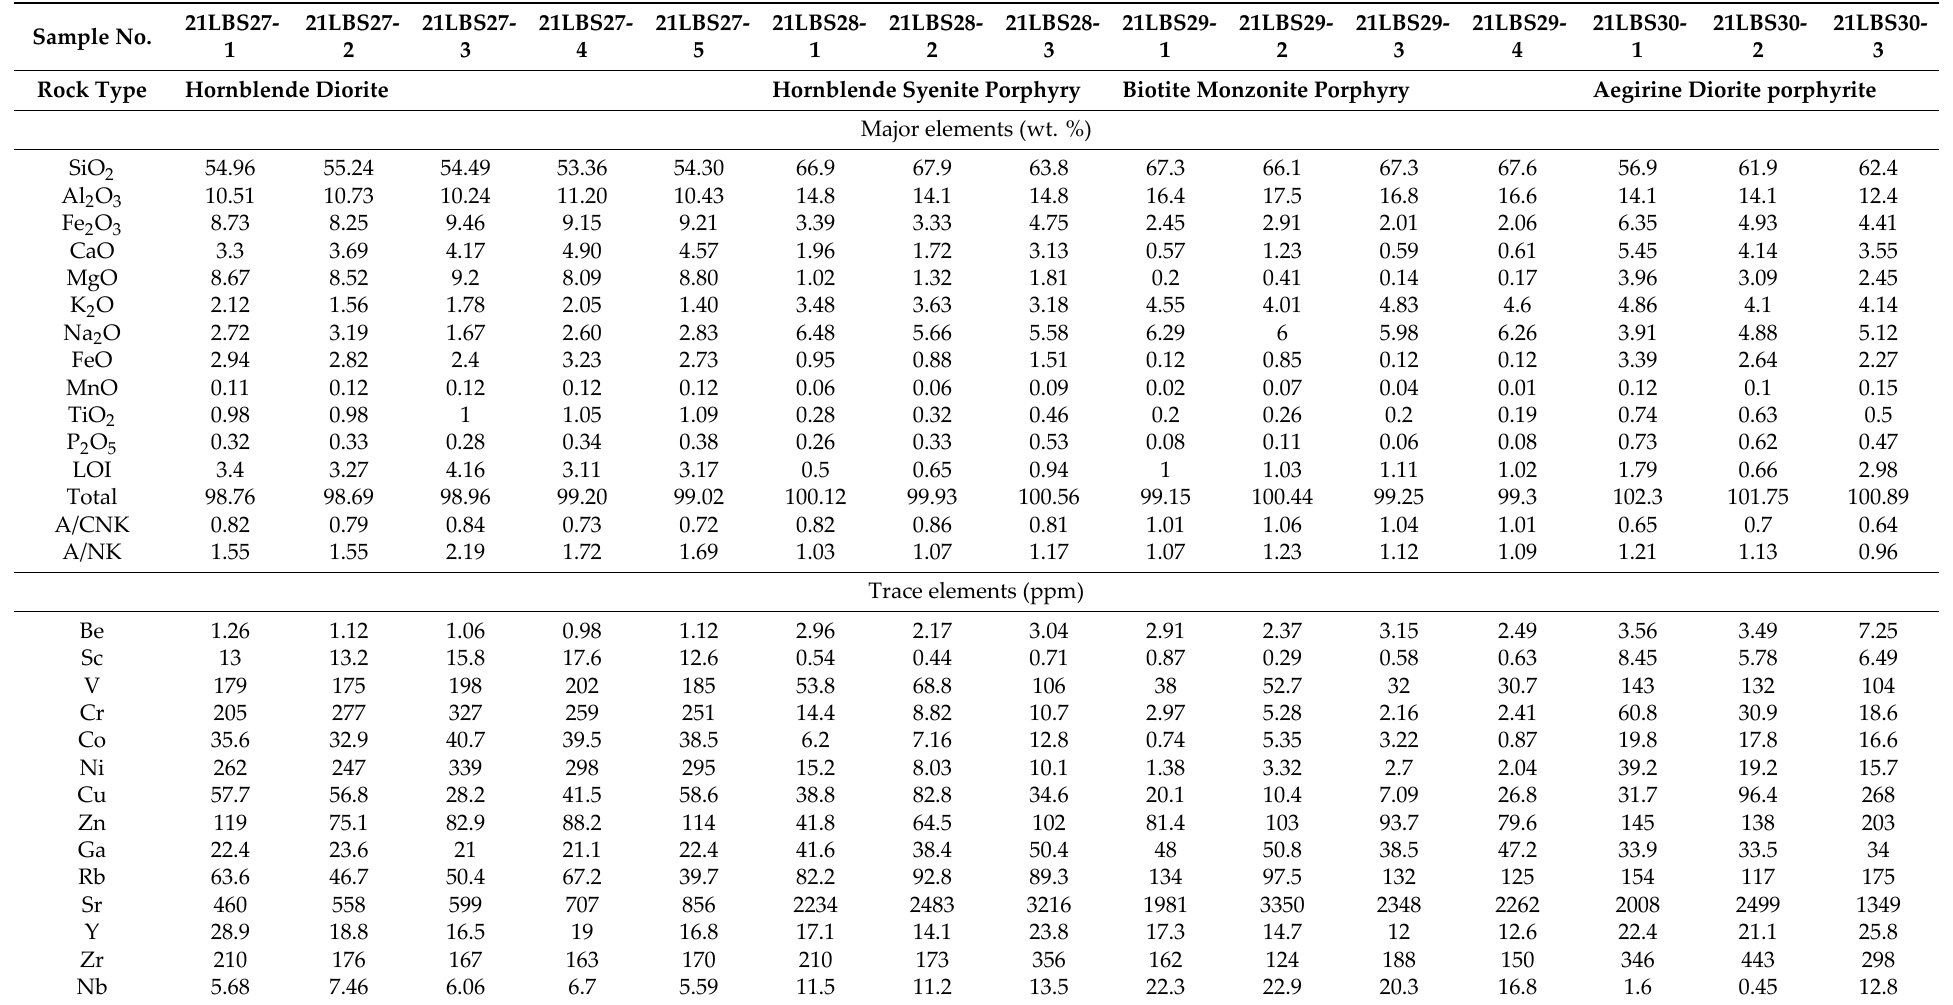
Table 3. Major (wt.%) and trace elements (ppm) of alkaline rocks from Longbaoshan alkaline complex. Sample